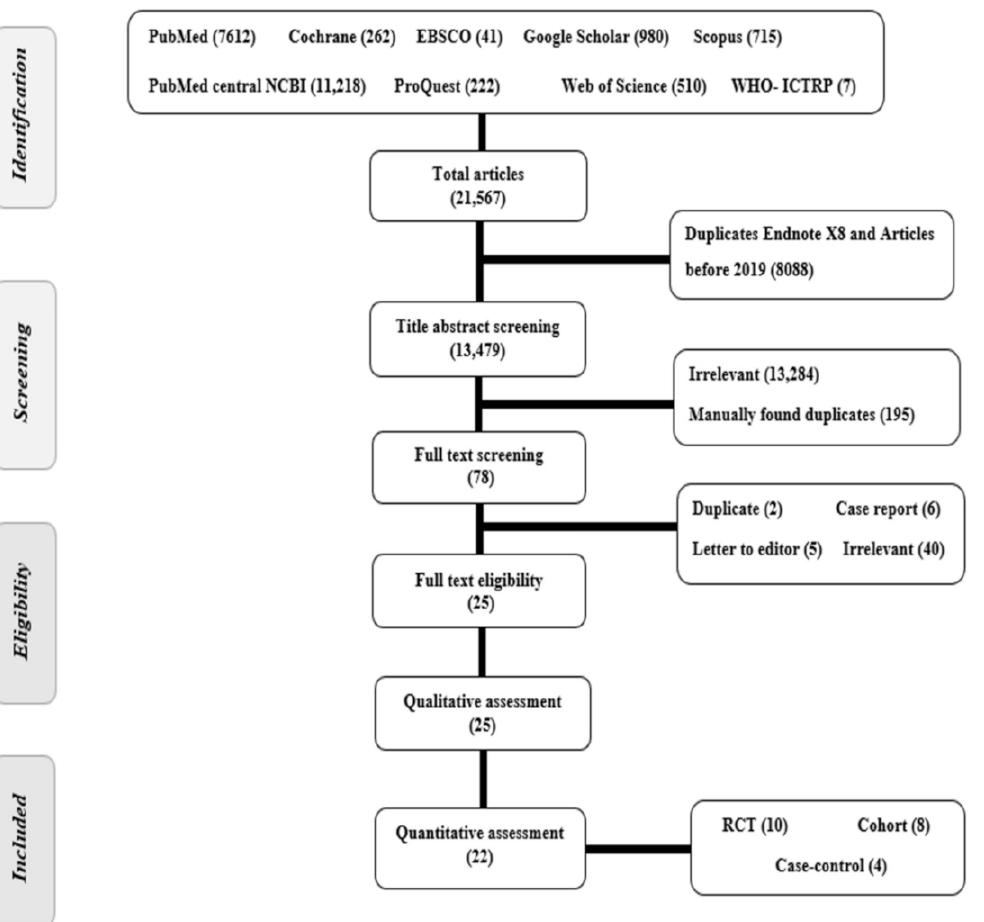
Figure 1. PRISMA flow chart of studies screened and a Summary of included studies in the qualitative analysis.